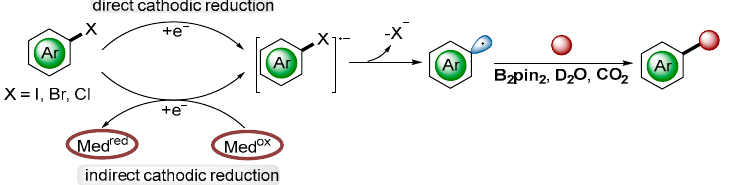
Figure 13. General mechanism for electroreductive transformation via aryl radical.